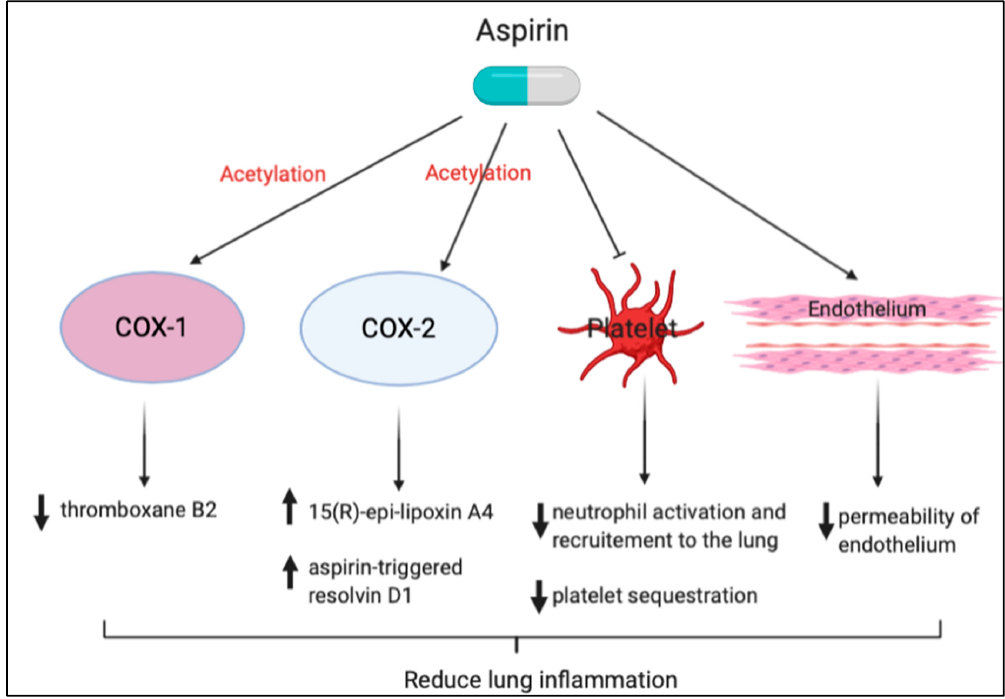
Figure 4. Protective effects of aspirin against lung inflammation. Neutrophil recruitment to the sites of lung injury may also be modulated through aspirin ‐ triggered anti ‐ inflammatory mediators.